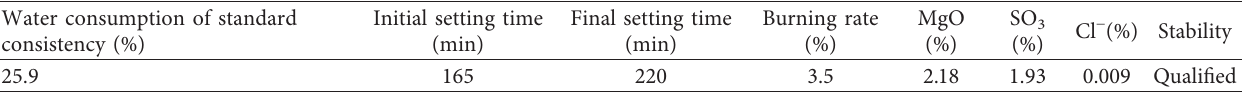
Table 1: Detailed parameters of P · O 42.5.